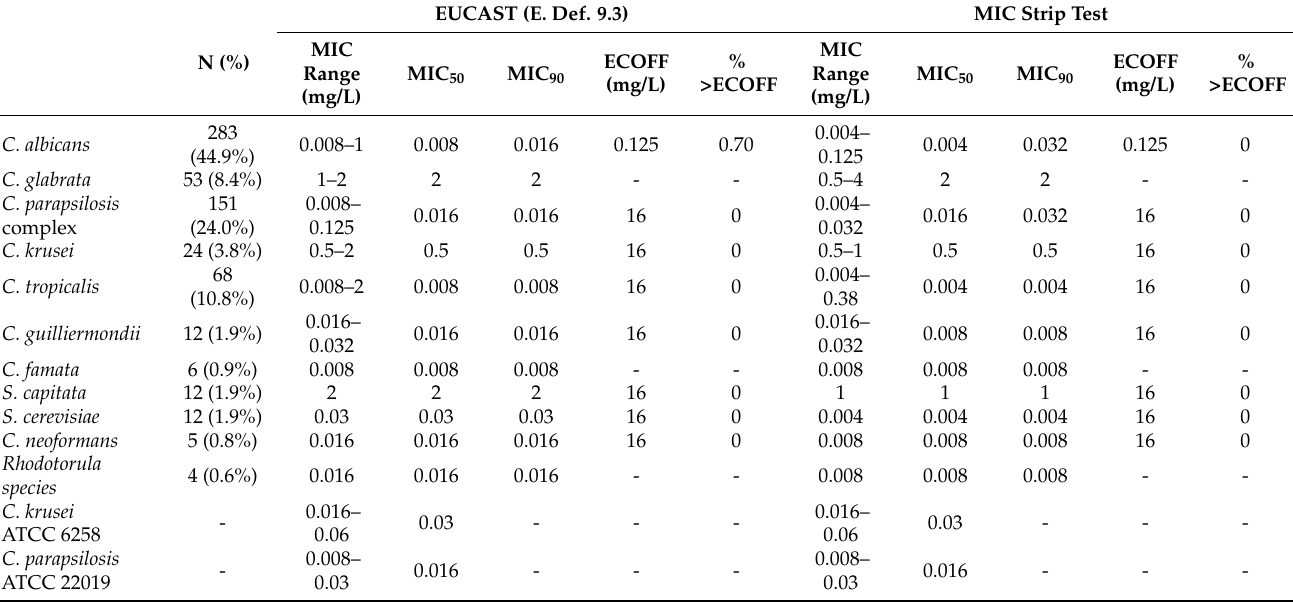
Table 1. Isavuconazole in vitro susceptibility data collected for enrolled yeast clinical isolates both through EUCAST broth and MIC Strip